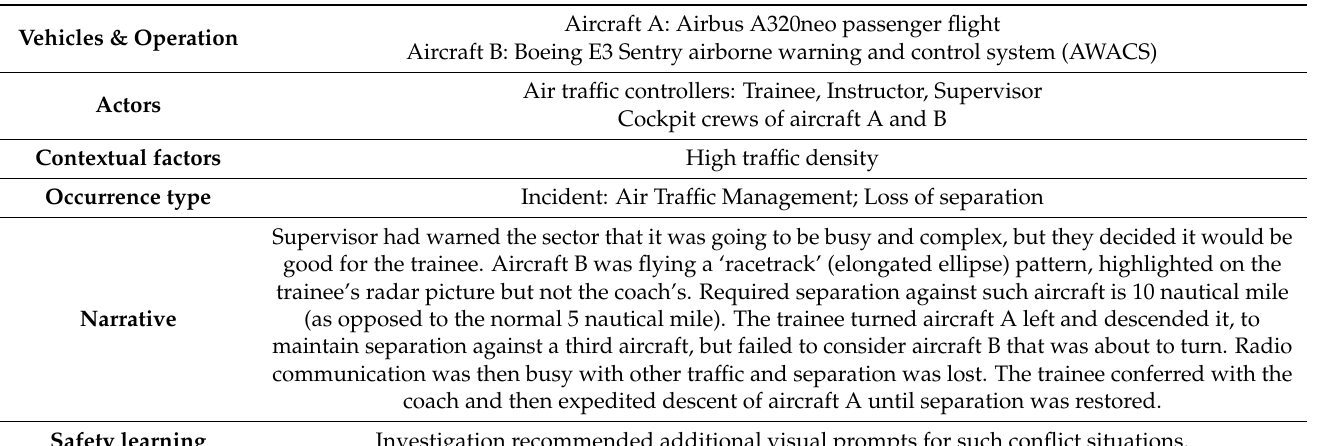
Table 1. Example of an aviation occurrence with main elements of the SHIELD taxonomy (see associated human factors in Table